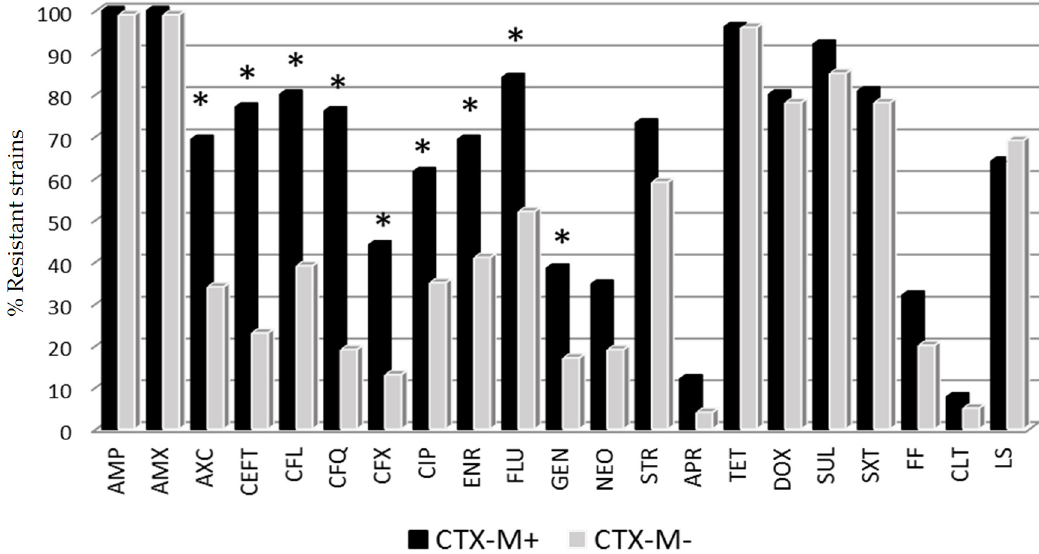
Figure 2. Percentage of E. coli resistant strains to di ff erent antimicrobial categories according to CTX-M gene expression. * Statistical di ff erences between CTX-M + (positive) and CTX-M– (negative) strains (Fisher exact test p < 0.05). Antibiotic abbreviations are shown in Table 1.